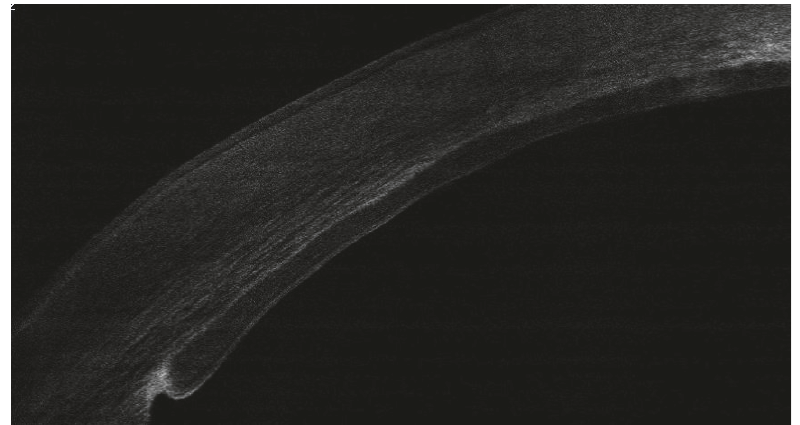
Figure 17: Another OCT showing side cut fi brosis and